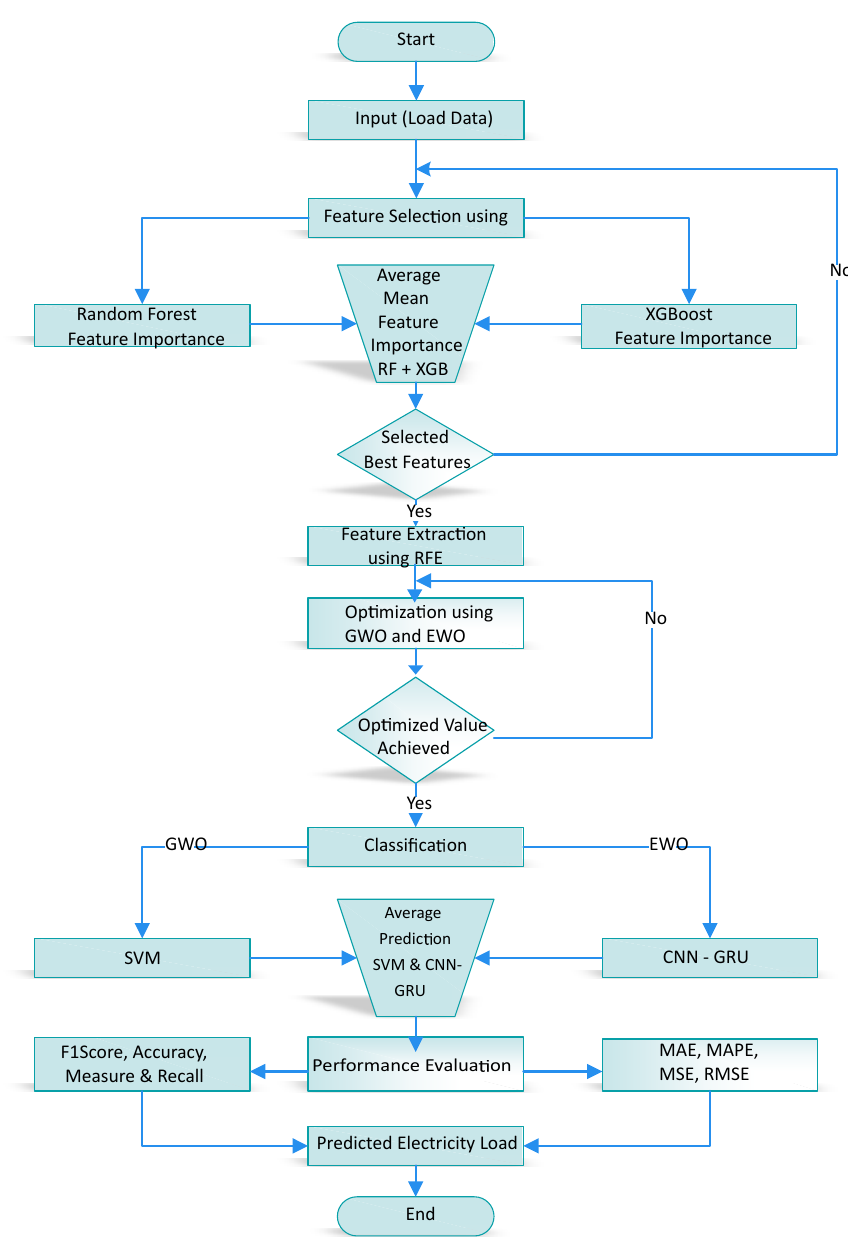
Figure 2. Detailed flowchart of the proposed model.